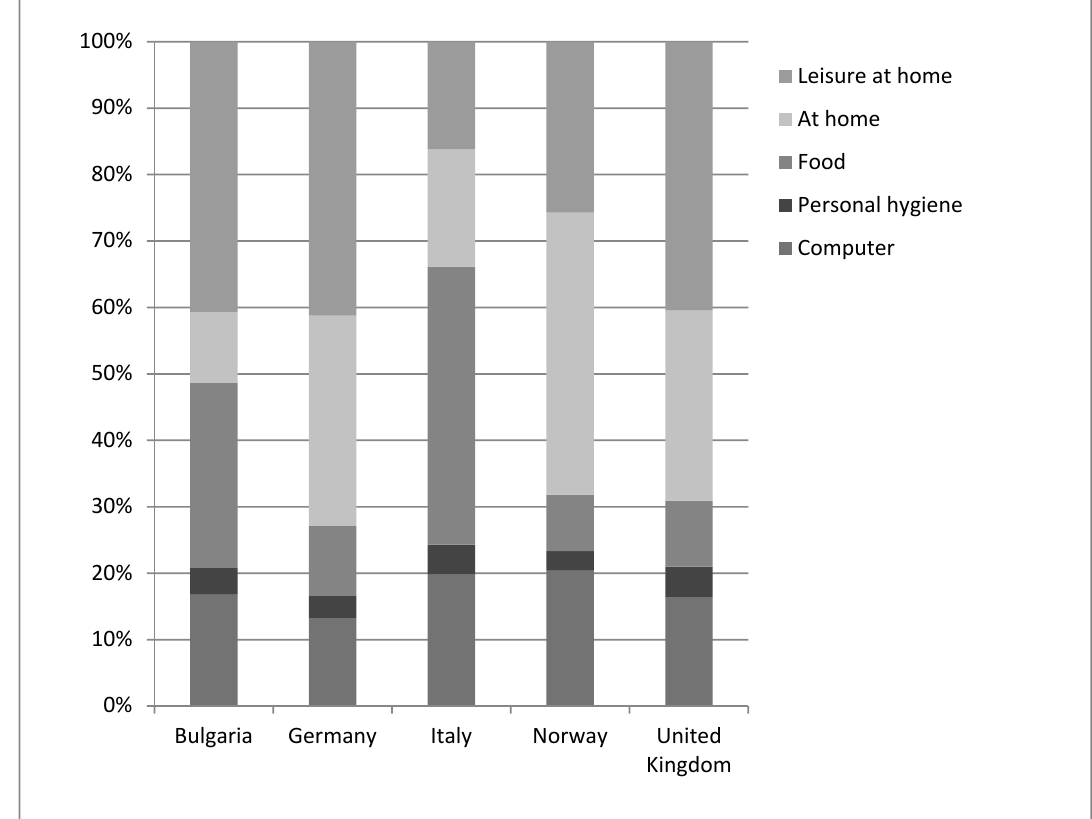
Figure 2. Share of time-use activities related to appliances in the household.